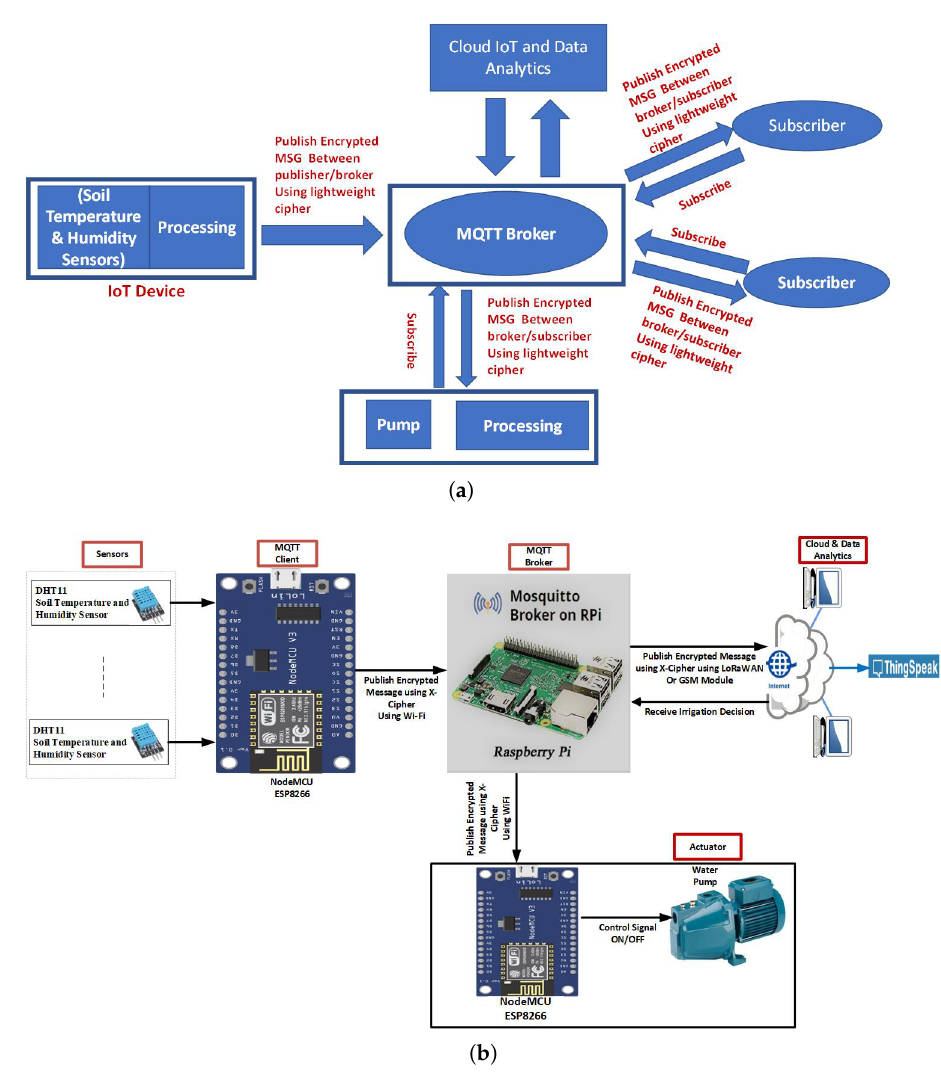
Figure 3. The proposed model. ( a ) proposed model architecture. ( b ) proposed model